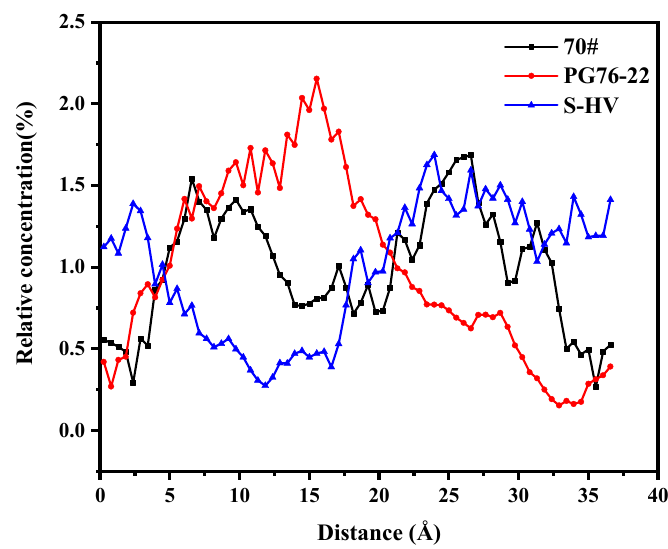
Figure 14. Solubility distribution of asphaltenes.